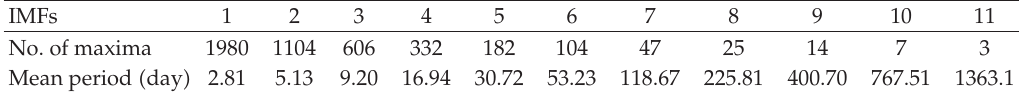
Table 2: Period statistics of daily maximum temperature